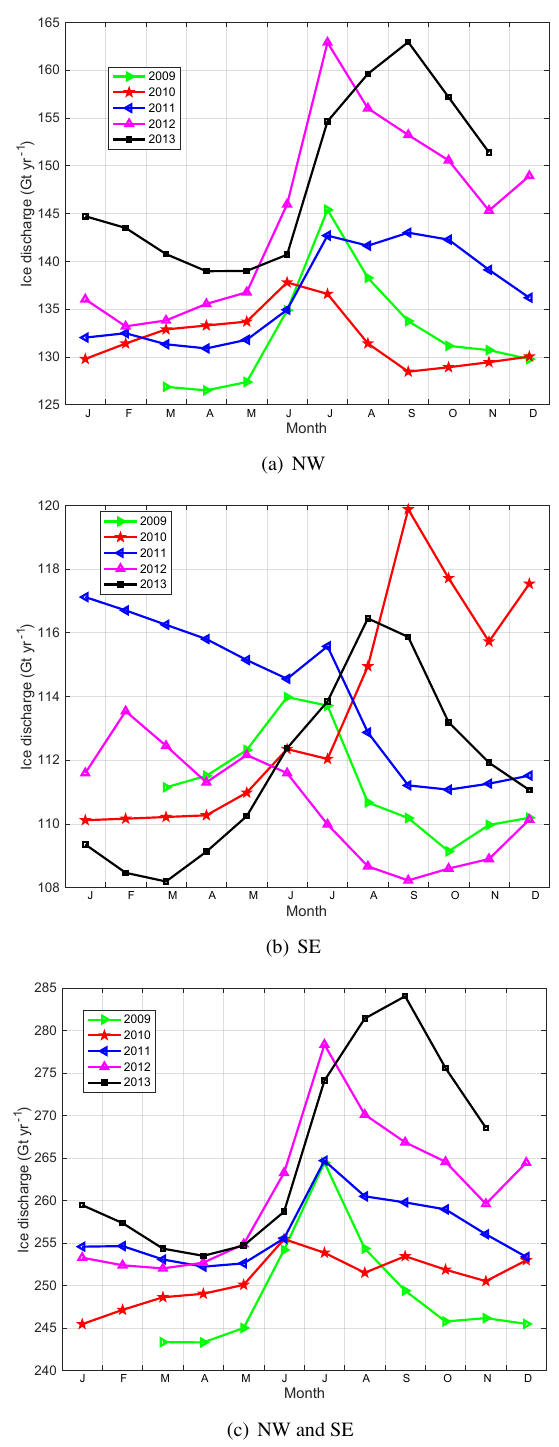
Figure 7. Monthly ice discharge estimates from 55 major marine- terminating glaciers for the glaciers in the NW drainage system (a) and the SE drainage system (b) individually, and for the NW and SE drainage systems together (c)